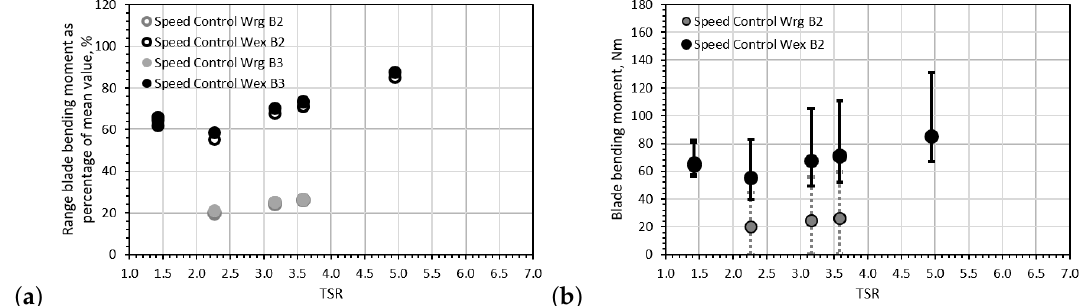
Figure 14. Average bending root moment fluctuations per wave period only for speed control cases: ( a ) the bending root moment fluctuation range as a percentage of the mean bending moment for each blade is presented and ( b ) the average maximum and minimum rotor thrust per wave period are indicated by the extremes of the error bars (only for blade